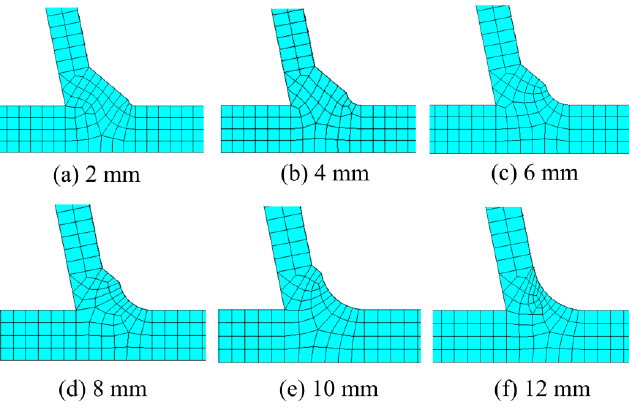
Figure 23. Finite element models of different grinding radii.